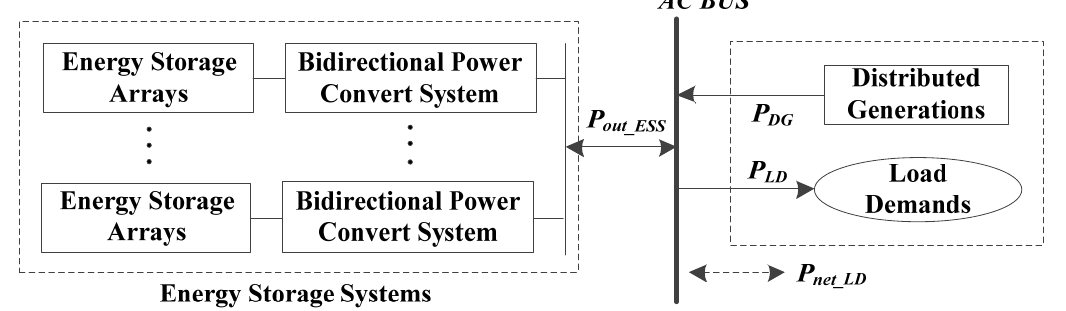
Figure 1. Configuration diagram of a standalone